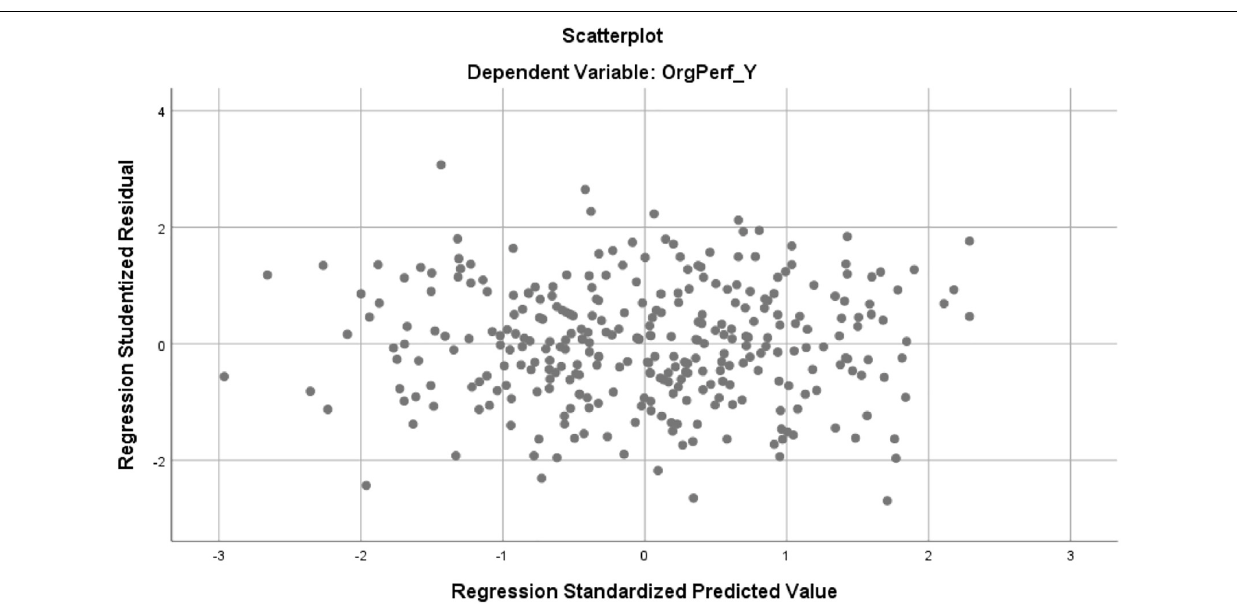
FIGURE 4 | Graph of the analysis of the variance of the